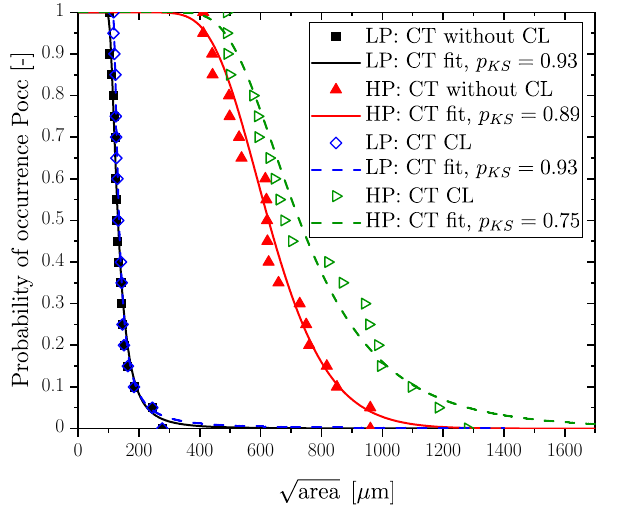
√ area perpendicular to the load direction for all layers of the thick-walled Figure 10. CDF of specimen. Table 4. The effect of clustering for high and low porosity